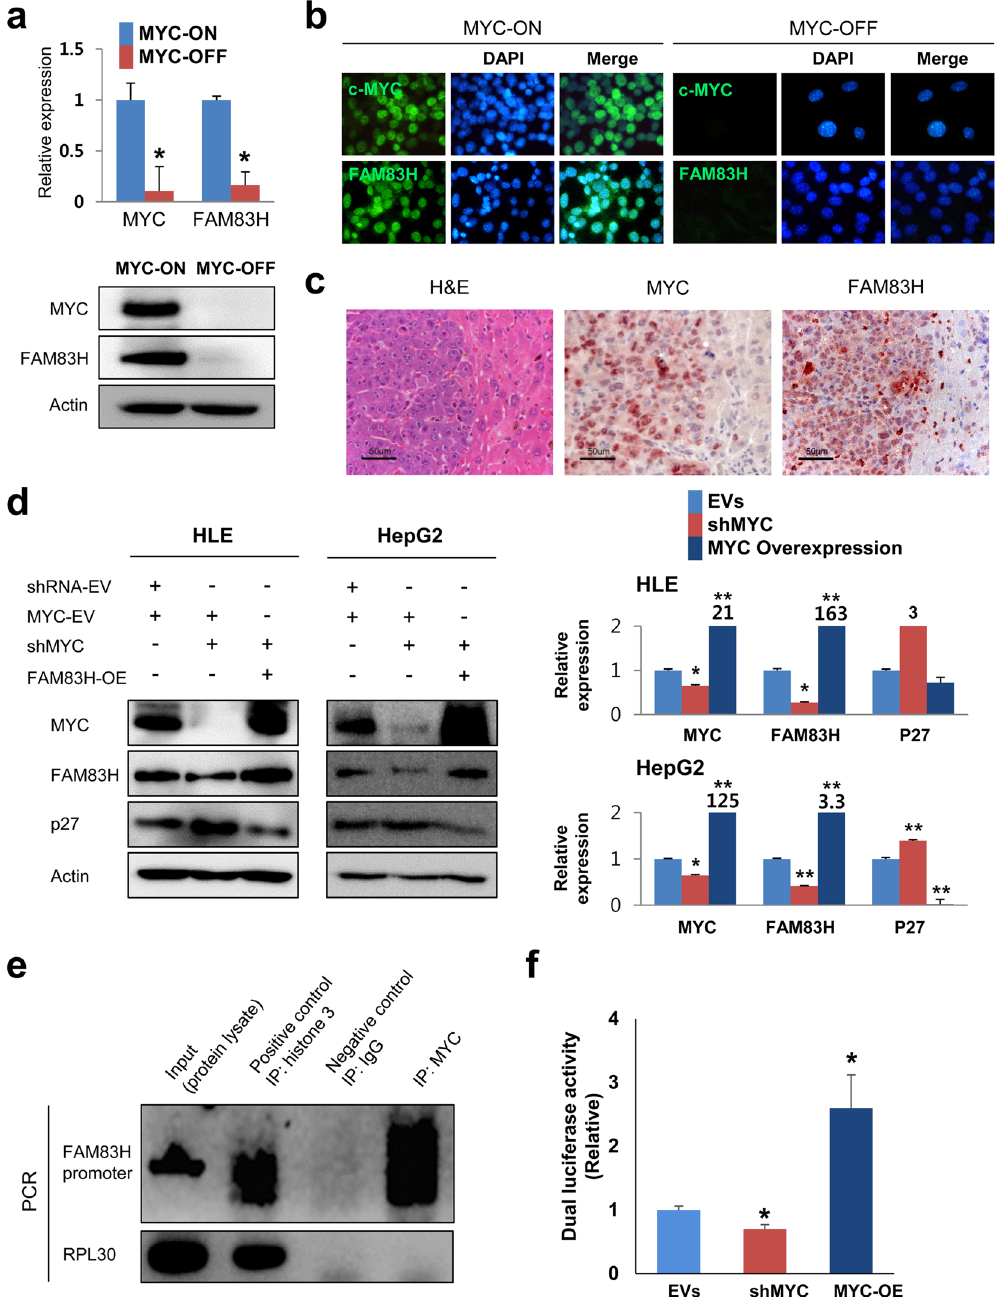
Figure 3. The expression of FAM83H is transcriptionally controlled by MYC. ( a ) In the cell lines derived from established liver tumors in the Tet-O-MYC mice, the expression of mRNA and protein of FAM83H decreased with inhibition of MYC by via 5 ng/ml doxycycline in culture media for five days. ( b ) The expression of FAM83H was decreased in MYC-OFF cells in immunofluoresence images. ( c ) Immunohistochemical expression of FAM83H is higher in MYC-expressing tumor cells compared with adjacent non-neoplastic hepatocytes in the tissue samples obtained from tumor-containing liver of Tet-O-MYC mice. ( d ) The expression of protein and mRNA of FAM83H decreased with knock-down of MYC and increased with overexpression of MYC in both HLE and HepG2 human hepatocellular carcinoma cell lines. In contrast, the expression of protein and mRNA of P27 increased with knock-down of MYC and decreased with overexpression of MYC in both HLE and HepG2 cells. ( e ) Chromatin immunoprecipitation assay shows the binding of MYC to the promotor of FAM83H. ( f ) Co-transfection of FAM83H promoter-luciferase reporter plasmid and a MYC overexpression vector significantly increased the luciferase activity. In contrast, co-transfection of FAM83H promoter-luciferase reporter plasmid and shRNA for MYC decreased the luciferase activity. EVs, co-transfection of empty vectors for shRNA and overexpression; OE, overexpression; the p values were calculated by Student’s t -test; * p < 0.05; ** p <